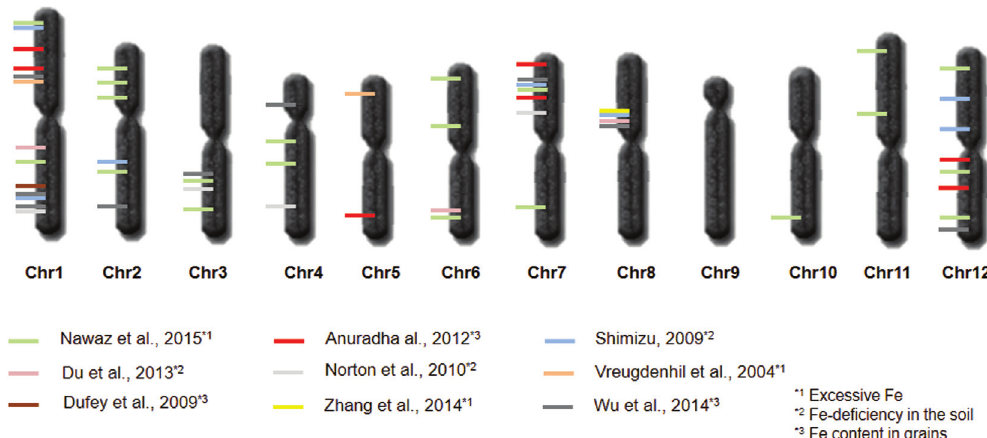
Figure 3 - QTLs related to Fe metabolism. Map with the location of different QTLs related to tolerance to low and/or excessive amounts of Fe in the soil, and/or related to the variation of Fe content in